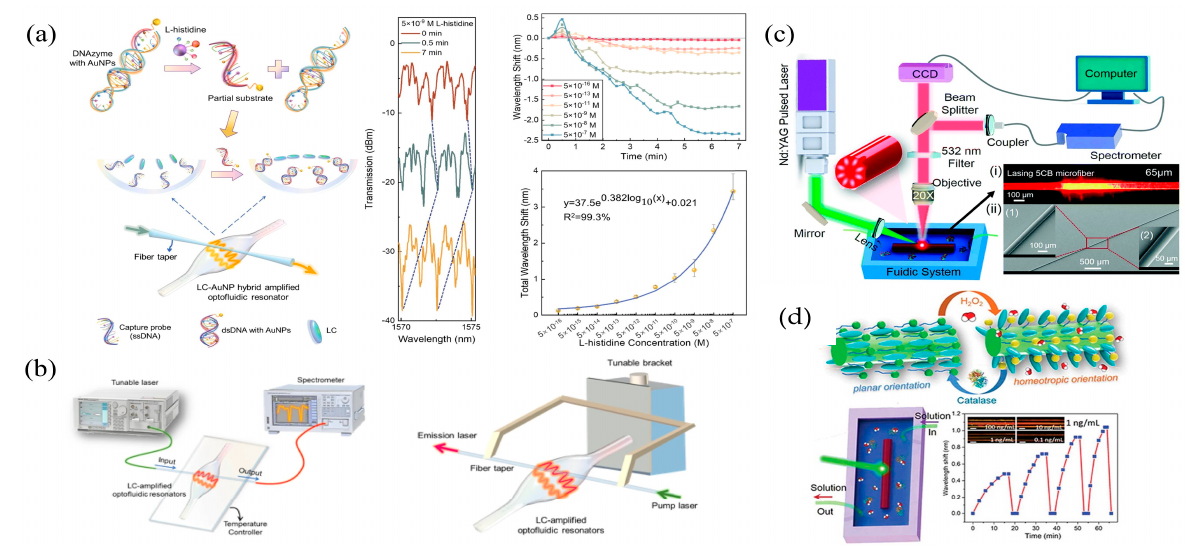
Figure 10. ( a ) Diagram of the DNAzyme optofluidic biosensor for L-histidine detection and the spectral response of the LC–AuNPs biosensor at different concentrations of L-histidine [134]; repro- duced with permission from Elsevier. ( b ) Schematic of the optofluidic LC biosensor for protein assay detection [135]; reproduced with permission from Springer. ( c ) Illustration of the experimental setup for monitoring the concentration of lipase using the LC microfiber biosensor [136]; reproduced with permission from Royal Society of Chemistry. ( d ) Principle of the orientation transition of LCs, and the time response curve for the shift of WGM wavelength under various catalase concentrations [137]; reproduced with permission from Taylor &